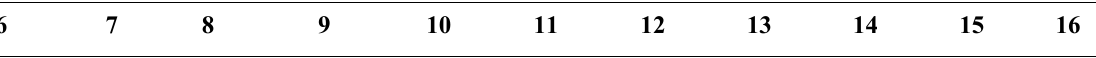
Table 2. Correlations among the measured parameters in the